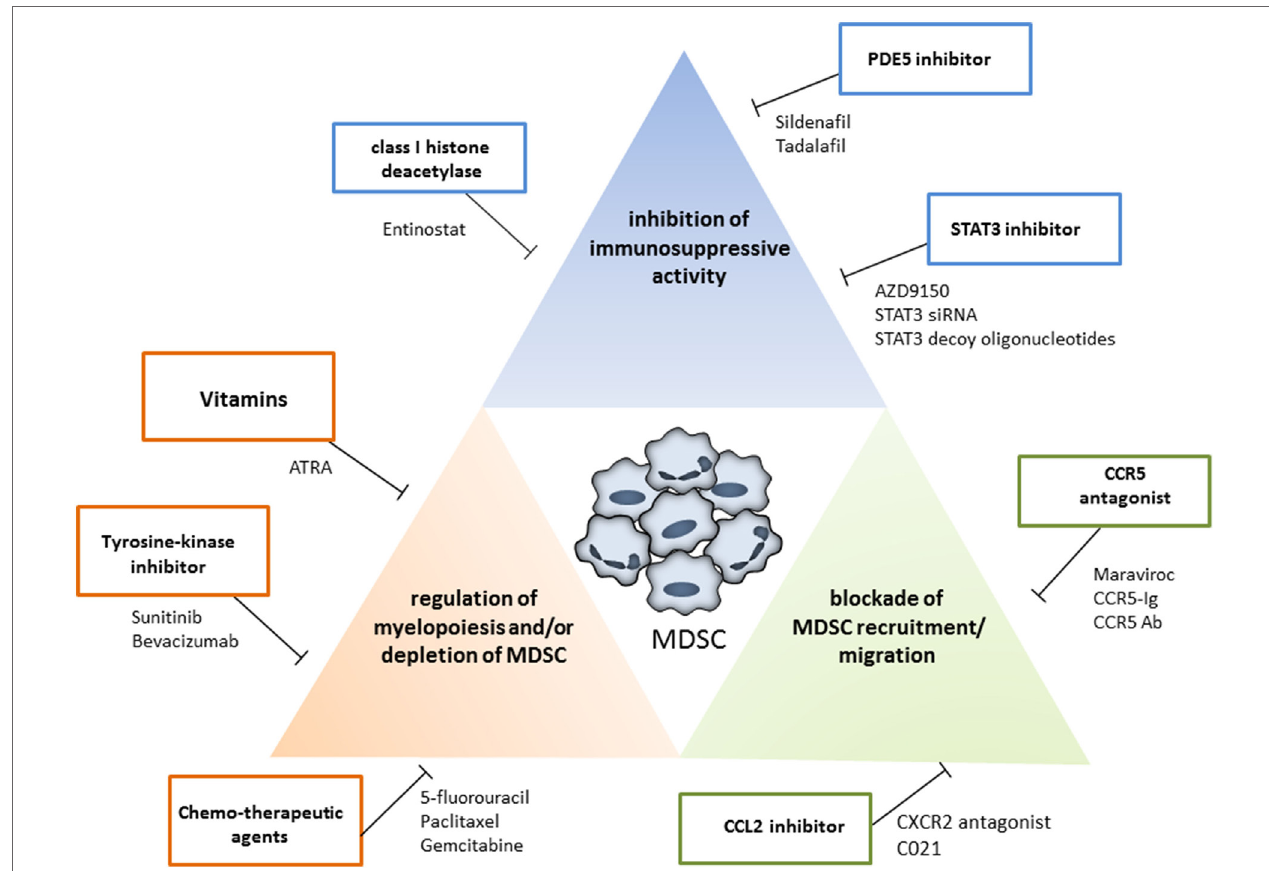
FiGURe 2 | Strategies for myeloid-derived suppressor cells (MDSC) targeting. The MDSC modulation could be achieved by the inhibition of their immunosuppressive activity (blue box), by the blockade of MDSC recruitment to the tumor site (green box), and by the regulation of myelopoiesis and/or depletion of MDSC (red box). Examples for each therapeutic approach are